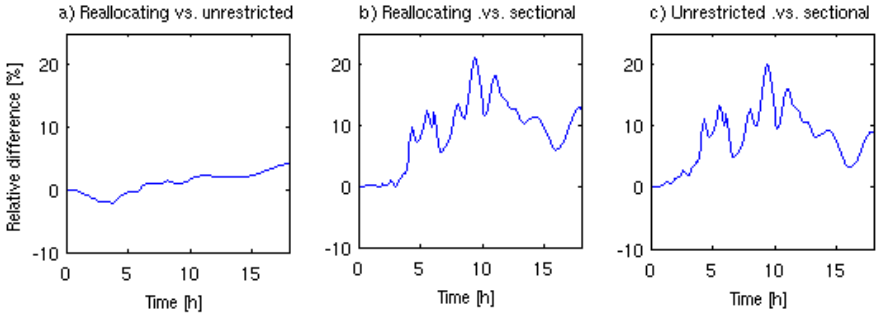
Fig. 14. The relative difference of the ACI parameter presented as mean over the 49 different distributions.